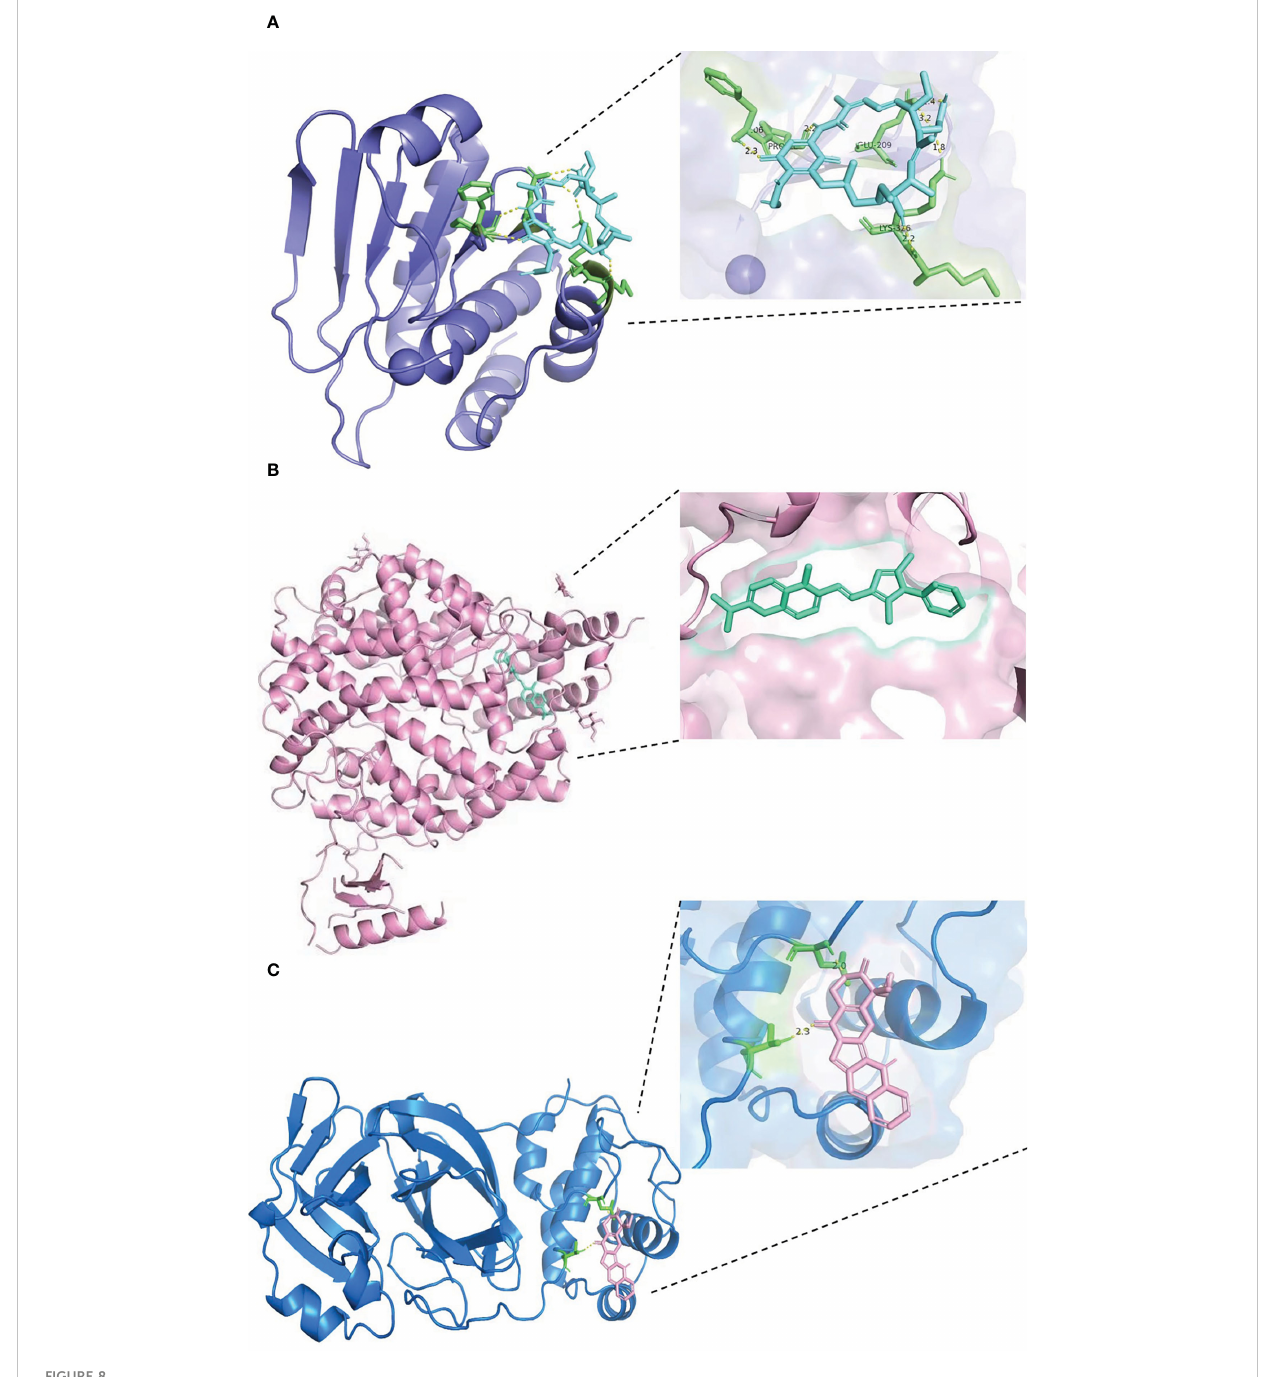
FIGURE 8 Results of molecular docking of drug and protein. Each fi gure shows the overall picture of the docking of protein and drug molecules and the enlarged picture of the docking part. (A) The docking diagram of DUSP6 with tanespimycin, with binding energy of − 5.67 kcal/mol. (B) The binding energy between ACE2 and pyrvinium is − 6.61 kcal/mol. (C) 3CLpro and camptothecin docking diagram, with binding energy of − 5.59